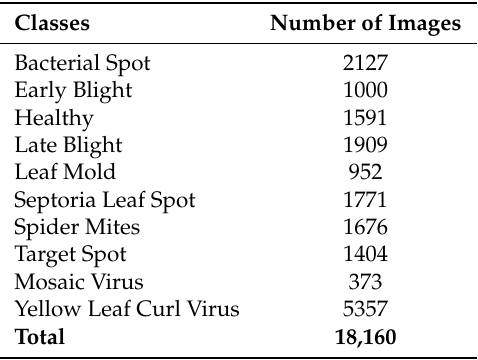
Figure 1. Sample images from PlantVillage - Dataset. (Top row, left to right): ( a ) Bacterial Spot, ( b ) Early Blight, ( c ) Healthy, ( d ) Late Blight, and ( e ) Leaf Mold. (Bottom row, left to right): ( f ) Septoria Leaf Spot, ( g ) Spider Mites, ( h ) Target Spot, ( i ) Mosaic Virus, and ( j ) Yellow Leaf Curl Virus. Table 2. Dataset